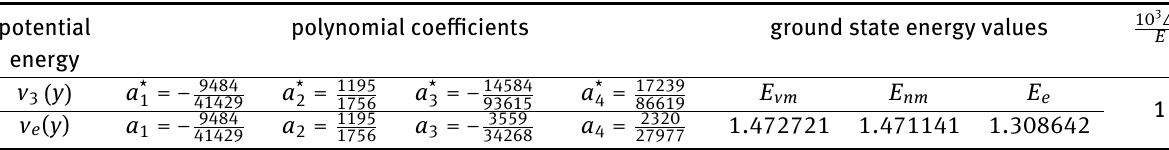
Table 3: Physical parameters for the potential energy v 3 ( y ) = x 2 − x 3 + x 4 − x 5 + x 6